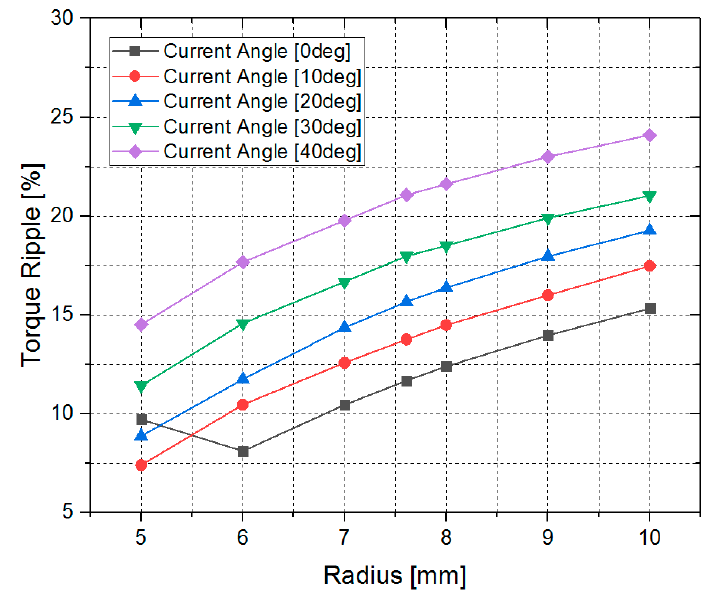
Figure 6. Comparative analysis of torque ripple according to notch radius.